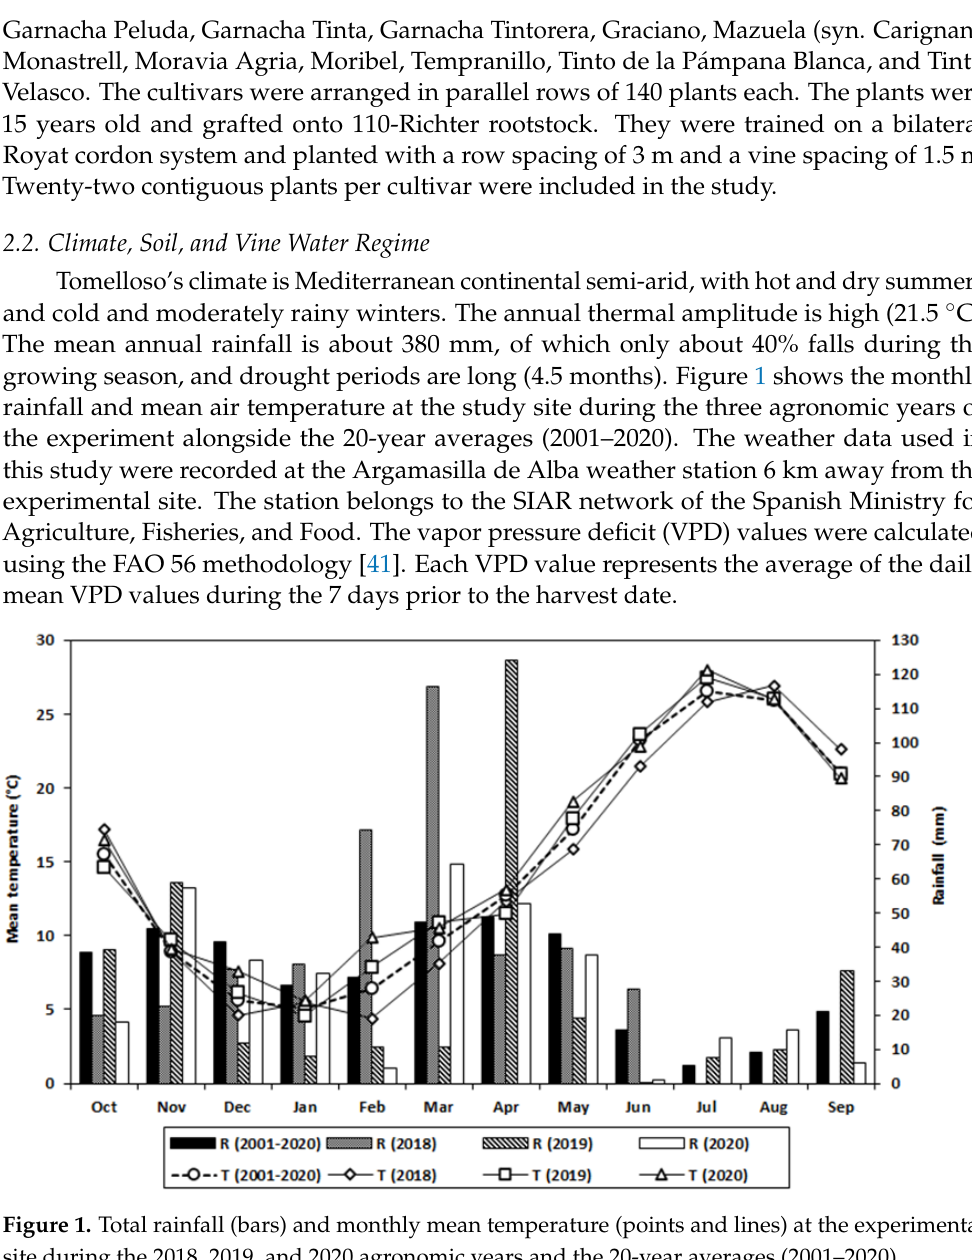
each year (after fruit set, when the branches stopped growing, and when the berries reached the size of a